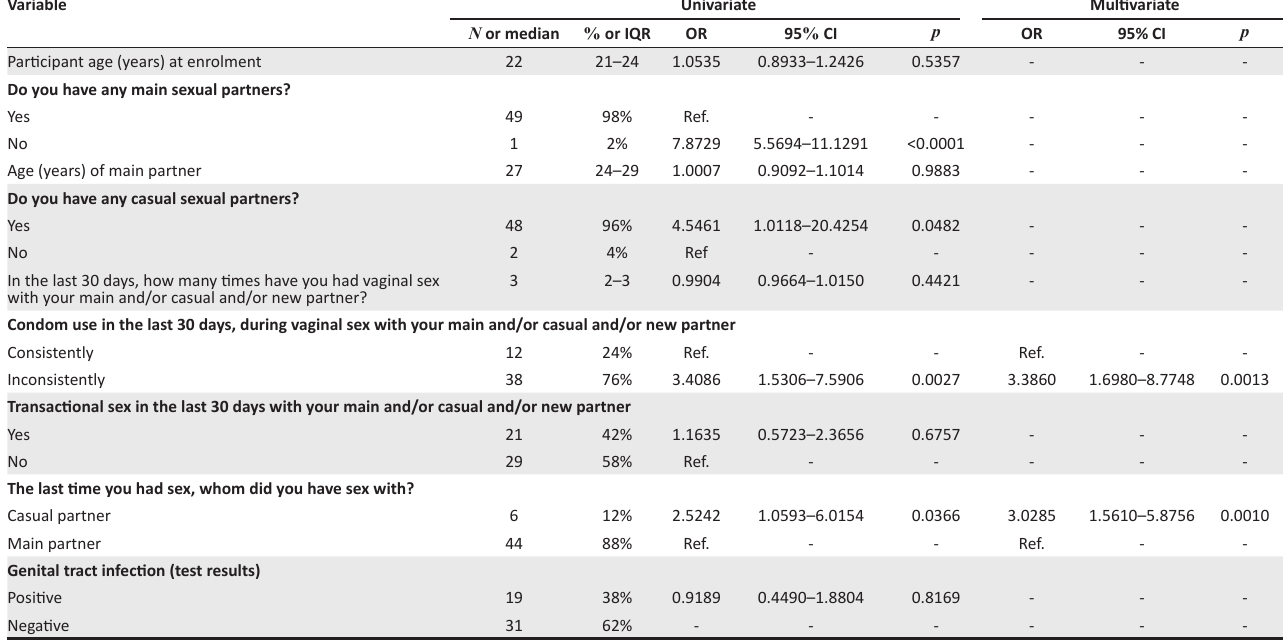
IQR, interquartile range; OR, odds ratio; CI, confidence